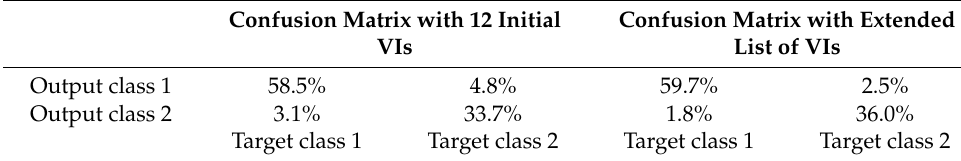
Table 6. Comparison between confusion